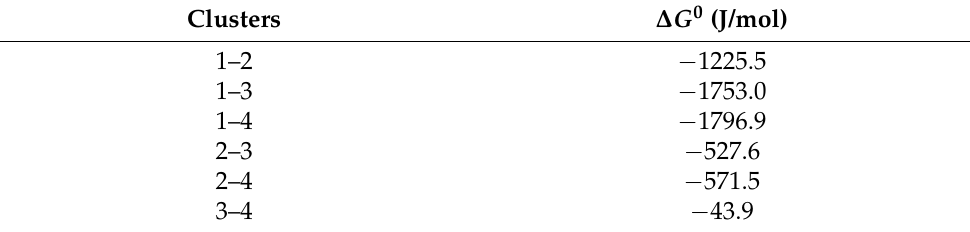
Table 1. Free energy values between clusters.